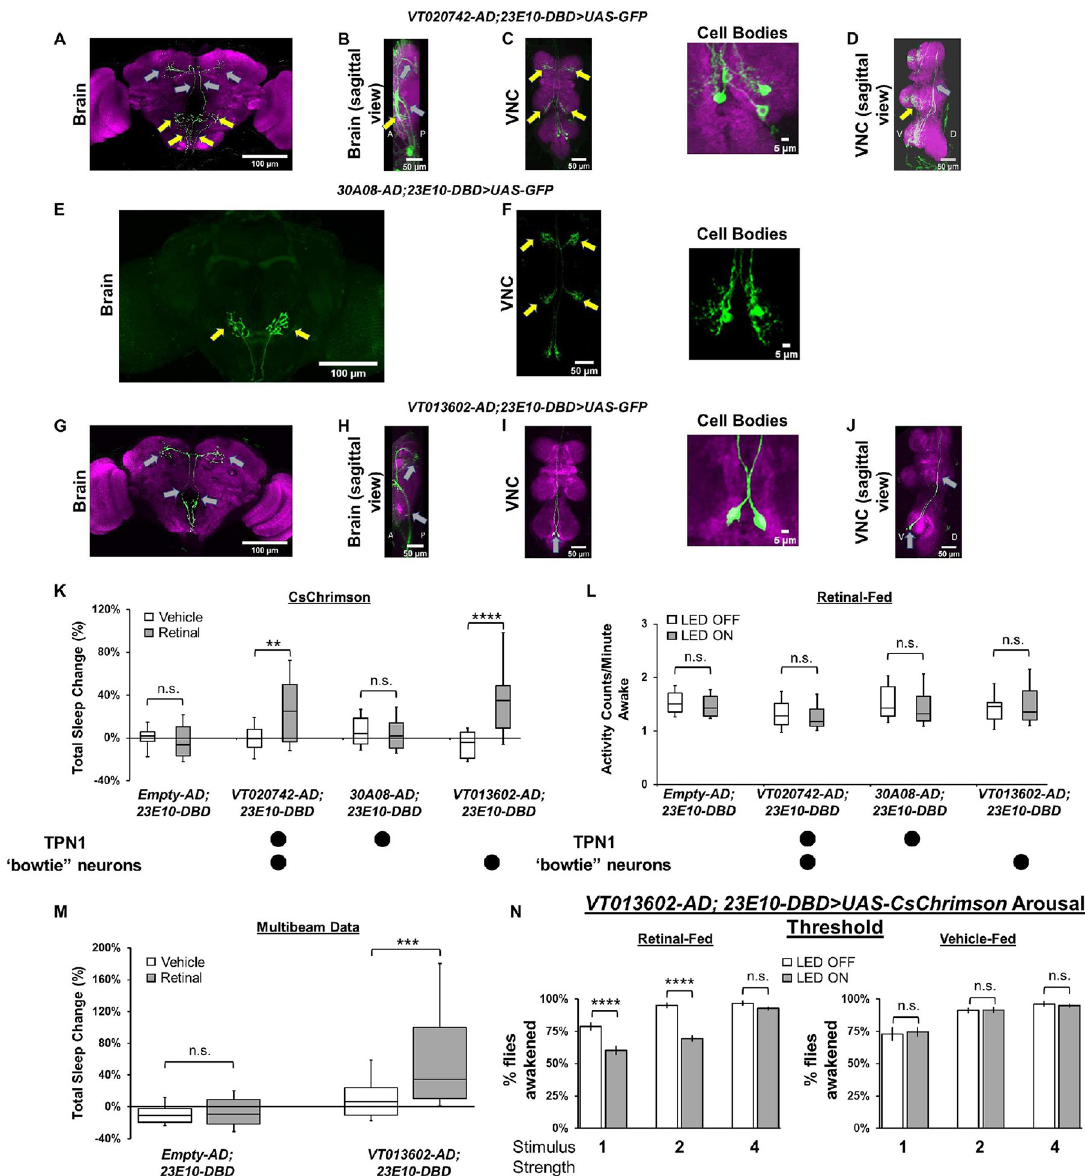
Fig 2. The AU : AbbreviationlistshavebeencompiledforthoseusedinFigs 2 to 5 : Pleaseverifythatallentriesarecorrect : 23E10-GAL4 driver contains sleep-promoting neurons that are located in the VNC. ( A-D ) Representative confocal stacks of a female VT020742-AD; 23E10-DBD > UAS-GFP brain (A), brain sagittal view (B), VNC (C), and VNC sagittal view (D). The cell bodies panel in (C) is a magnified view of the metathoracic area of the VNC. Yellow arrows indicate TPN1-like processes and gray arrows “bowtie” processes. Green, anti-GFP; magenta, anti-nc82 (neuropile marker). A = anterior, P = posterior, V = ventral, and D = dorsal. ( E, F ) Representative confocal stacks of a female 30A08-AD; 23E10-DBD > UAS-GFP brain (E) and VNC (F). The cell bodies panel in (F) is a magnified view of the metathoracic area of the VNC. Yellow arrows indicate TPN1 processes in the brain and VNC. Green, anti-GFP. ( G–J ) Representative confocal stacks of a female VT013602-AD; 23E10-DBD > UAS-GFP brain (G), brain sagittal view (H), VNC (I), and VNC sagittal view (J). The cell bodies panel in (I) is a magnified view of the metathoracic area of the VNC. Gray arrows indicate “bowtie” processes and cell bodies in (I) and (J). Green, anti-GFP; magenta, anti-nc82 (neuropile marker). A = anterior, P = posterior, V = ventral, and D = dorsal. ( K ) Box plots of total sleep change in % for control ( Empty-AD; 23E10-DBD > UAS-CsChrimson ), VT020742-AD; 23E10-DBD > UAS-CsChrimson , 30A08-AD; 23E10-DBD > UAS-CsChrimson and VT013602-AD; 23E10-DBD > UAS-CsChrimson vehicle-fed and retinal-fed female flies upon 627-nm LED stimulation. Two-way ANOVA followed by Sidak’s multiple comparisons revealed that retinal-fed VT020742-AD; 23E10-DBD > UAS-CsChrimson and VT013602-AD; 23E10-DBD > UAS-CsChrimson flies increase sleep significantly when stimulated with 627-nm LEDs when compared with vehicle-fed flies. �� P < 0.01, ���� P < 0.0001, n.s. = not significant, n = 13–34 flies per genotype and condition. ( L ) Box plots of locomotor activity counts per minute awake for retinal-fed flies presented in (K). Two-way repeated measures ANOVA followed by Sidak’s multiple comparisons test show that locomotor activity per awake time is not affected when the flies are stimulated with 627-nm